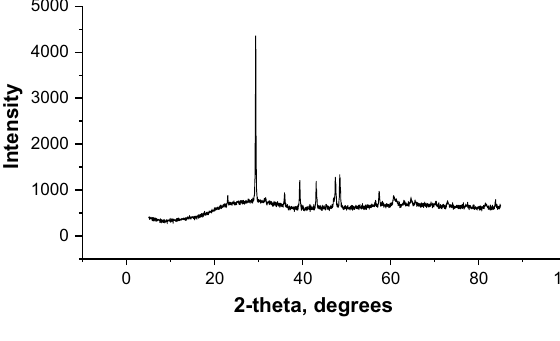
Fig. 3 XRD pattern for WM-Fe